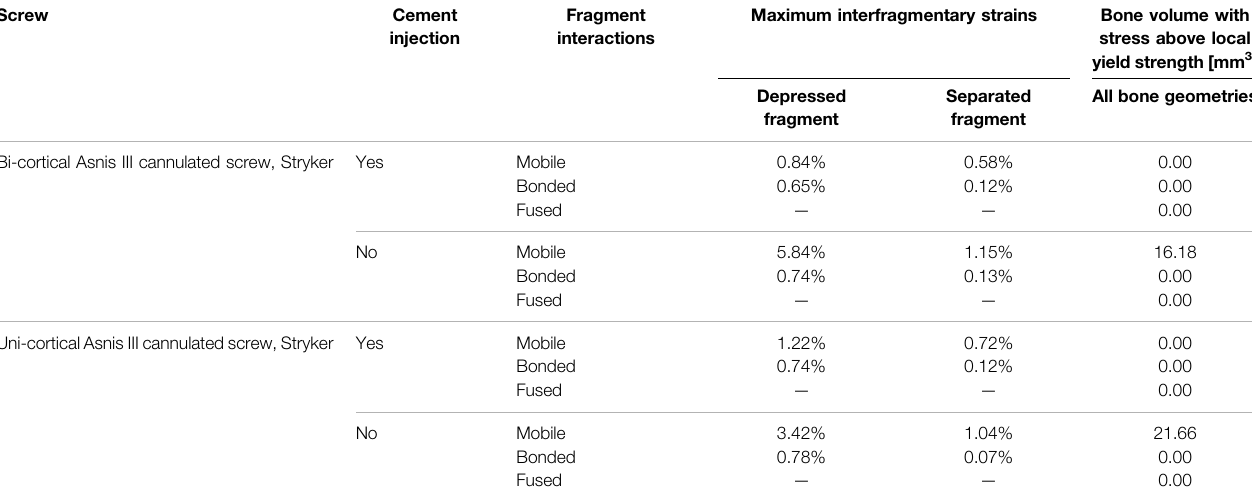
( Figure 5B ). Full weight-bearing at an intermediary bone